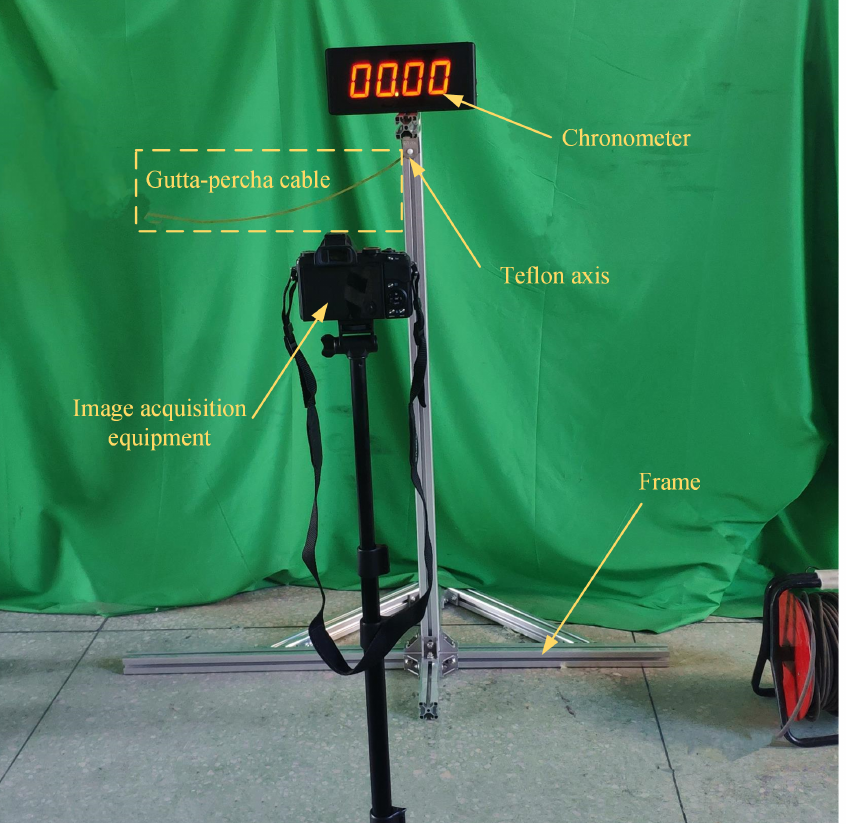
Figure 9. The structure of experimental